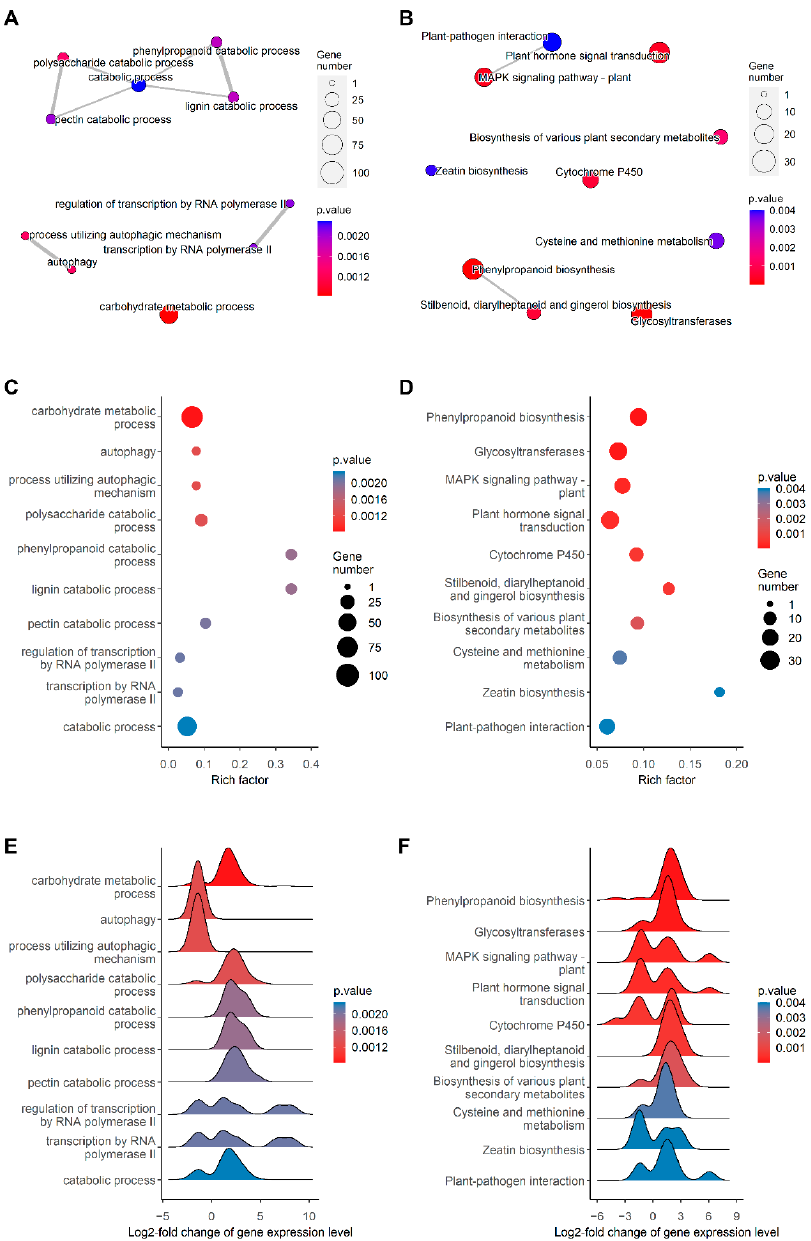
Figure 5. Enrichment analysis of DEGs based on the functional annotation from Gene Ontology and KEGG databases. The DEGs were identified using DESeq2 settings of adjusted p -value < 0.1 and absolute log 2 fold-change > 0.5. The Gene Ontology enrichment analysis was applied using function “gseGO” of the R package “clusterProfiler”, and the KEGG pathway enrichment analysis was applied using function “enricher” of the same package. The plots show the top ten GO terms and KO terms ranked in the order of descending p -value. ( A ) Emap plot of Gene Ontology biological processes. Mutually overlapping gene sets tend to cluster together. The dot size indicates the number of genes belonging to the GO term, and the color indicates the significance of the term. ( B ) Emap plot of KEGG pathways. ( C ) Dot plot of the enriched GO terms. The dot size indicates the number of genes belonging to the GO term, and the color indicates the significance of the term. Rich factor is the ratio of the number of DEGs in the term to the total number of the annotated genes in the term. ( D ) Dot plot of the enriched KO terms. ( E ) Ridge plot of the GO terms showing the distribution of the gene expression level of the DEGs in the terms. The gene expression level is measured in log 2 -TPM. ( F ) Ridge plot of the KO